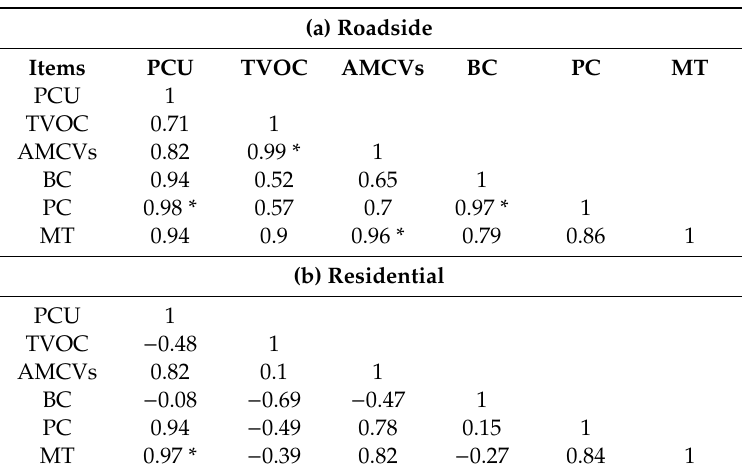
Table 4. Correlation of tra ffi c volumes, volatile organic compounds and ambient monitoring comparison value.